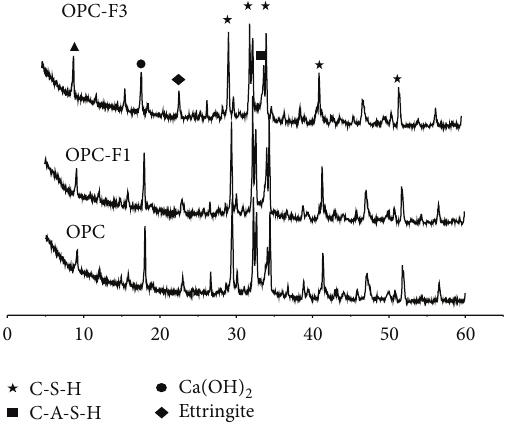
Figure 12: Specimen incorporating calcium formate (3 days).